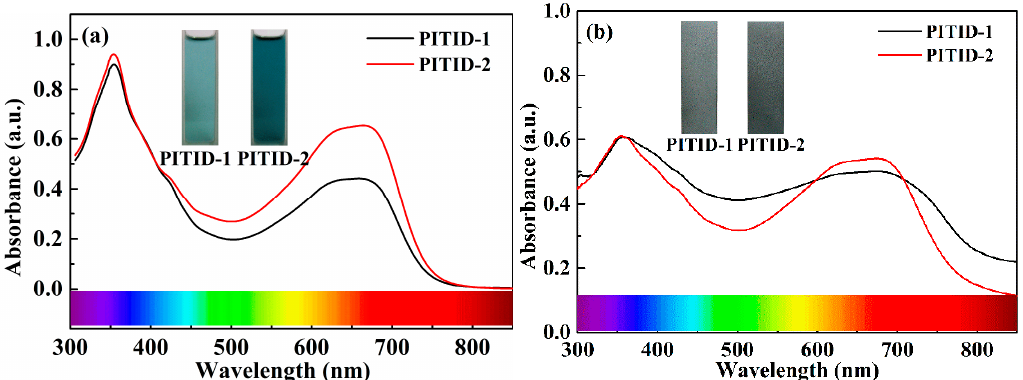
Figure 4. UV-vis absorption spectra of PITID-1 and PITID-2 in chloroform ( a ) and as thin films ( b ). The inserted pictures show the color of the polymers in different states.